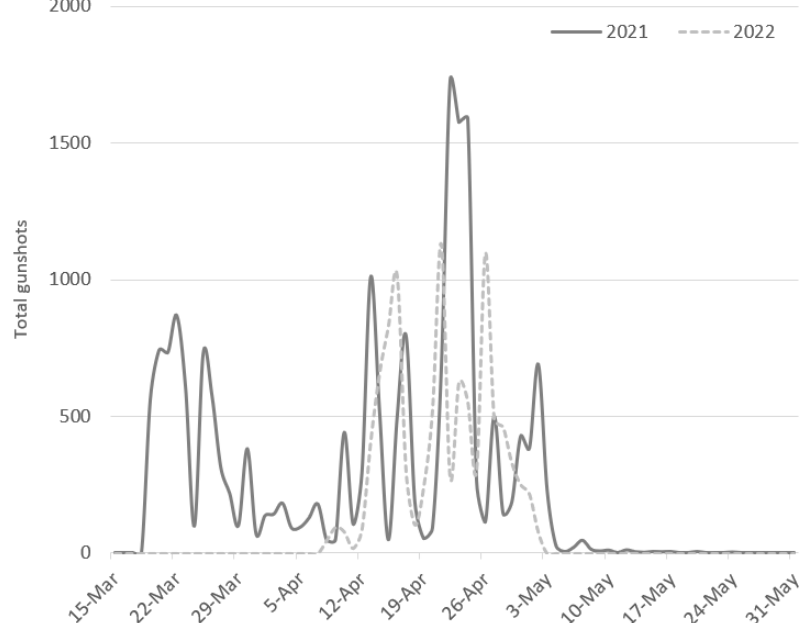
Figure 3. Daily variation in the total poaching activity at nine sites during the 2021 and 2022 (15 March to 31 May) spring migrations. Data from the Kalipado (Zakynthos) acoustic sensor are not included for the sake of comparison, as that sensor malfunctioned in 2022. Almost all the gunshots in March were recorded at the Vasilikos (Zakynthos)